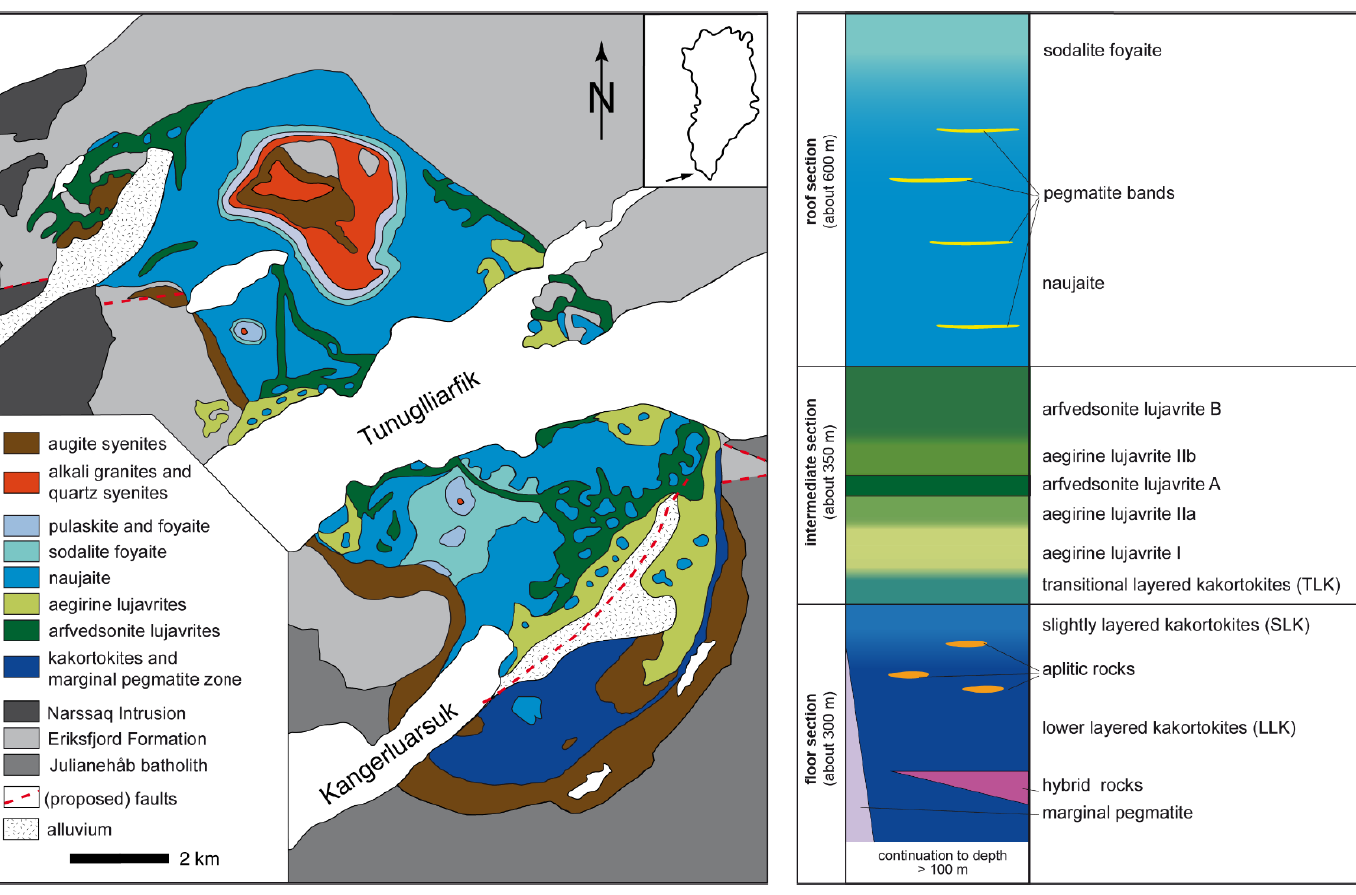
Figure 1. Schematic map from the Ilímaussaq Complex ( left ) and division of the agpaitic rocks ( right ) into three sections.